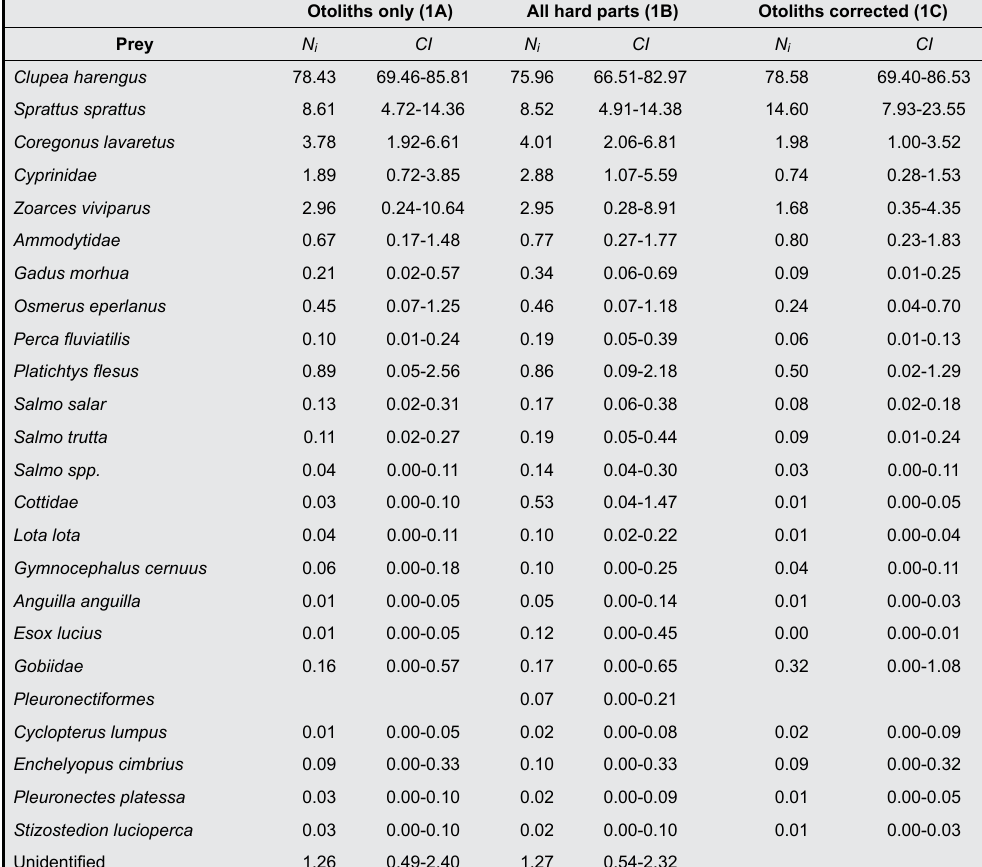
Table 7. Estimated relative numerical contribution in percent (N i ) of consumed prey individuals with upper and lower range of the 95% confidence interval (CI). Indices were calculated using otoliths only (method A), all recovered hard-part structures (method B) and otoliths with numerical and size correction factors applied (method C), for all data pooled (model 1) in Table 7a and seal weighted average (model 2) in Table